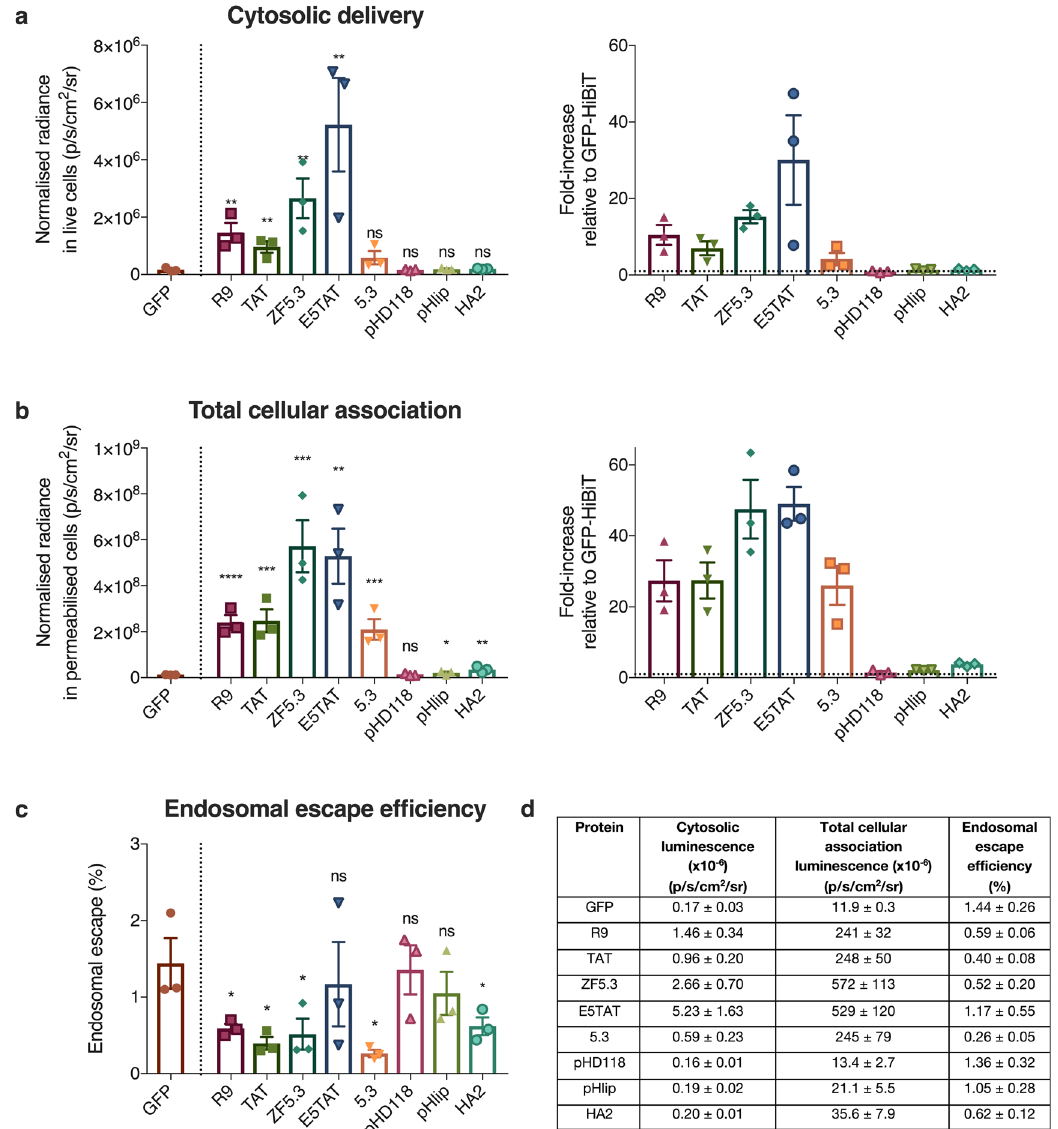
Fig. 4 Cationic EEPs increase cytosolic delivery of GFP but do not increase endosomal escape ef fi ciency. a Cytosolic luminescent signal of EEP-GFP- HiBiT in HEK293-LSA cells and fold-increase in signal with respect to GFP (represented by dotted line = 1). HEK293-LSA cells were incubated with EEP- GFP-HiBiT proteins at 1 µ M for 4 h. Data represents mean ± SEM, n = 3 independent experiments. Kruskal – Wallis with uncorrected Dunn ’ s test was used to analyse the data. b Total cellular association of EEP-GFP-HiBiT in HEK293-LSA cells and fold-increase with respect to GFP (represented by dotted line = 1) determined by permeabilising the cells using 0.01% w/v digitonin. Data represents mean ± SEM, n = 3 independent experiments. Kruskal – Wallis with uncorrected Dunn ’ s test was used to analyse the data. c Endosomal escape ef fi ciency of EEP-GFP-HiBiT proteins determined by ratioing cytosolic signal with total cellular association. Data represents mean ± SEM, n = 3 independent experiments. Kruskal – Wallis with uncorrected Dunn ’ s test was used to analyse the data. d Summary of cytosolic luminescence, total cellular association luminescence and endosomal escape ef fi ciency for all proteins. Data represents mean ± SEM, n = 3 independent experiments. Kruskal – Wallis with uncorrected Dunn ’ s test was used to analyse the data, with GFP being the control group. ns (not signi fi cant) denotes p > 0.05, * p ≤ 0.05, ** p ≤ 0.01, *** p ≤ 0.001 and **** p ≤ 0.0001. Source data are provided as a Source Data fi